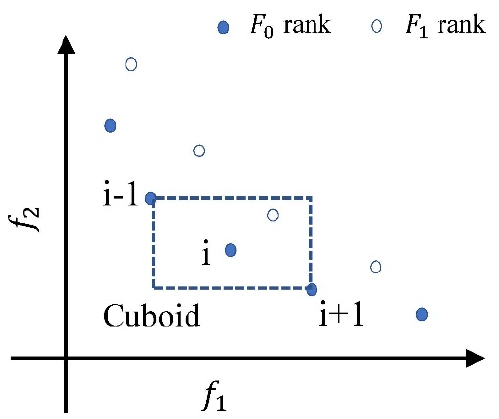
which divides the population into separate fronts [34].